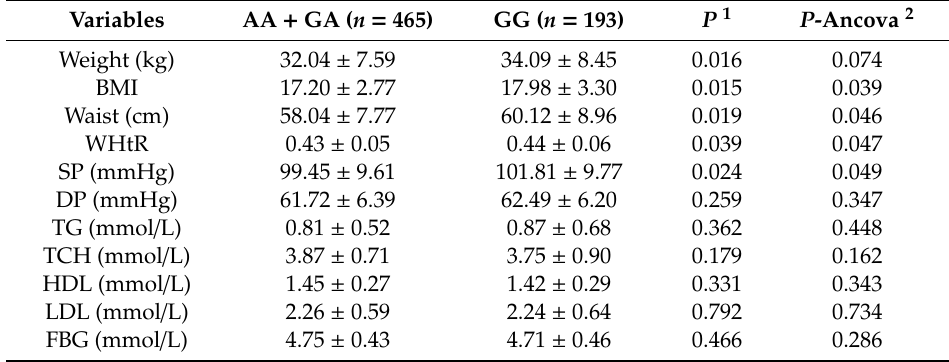
Table 3. Obesity-related variables according to the CMTM7 rs347134 genotype for male children. Variables